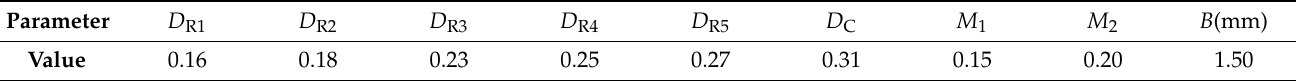
Table 3. Structural parameters of hollow fan